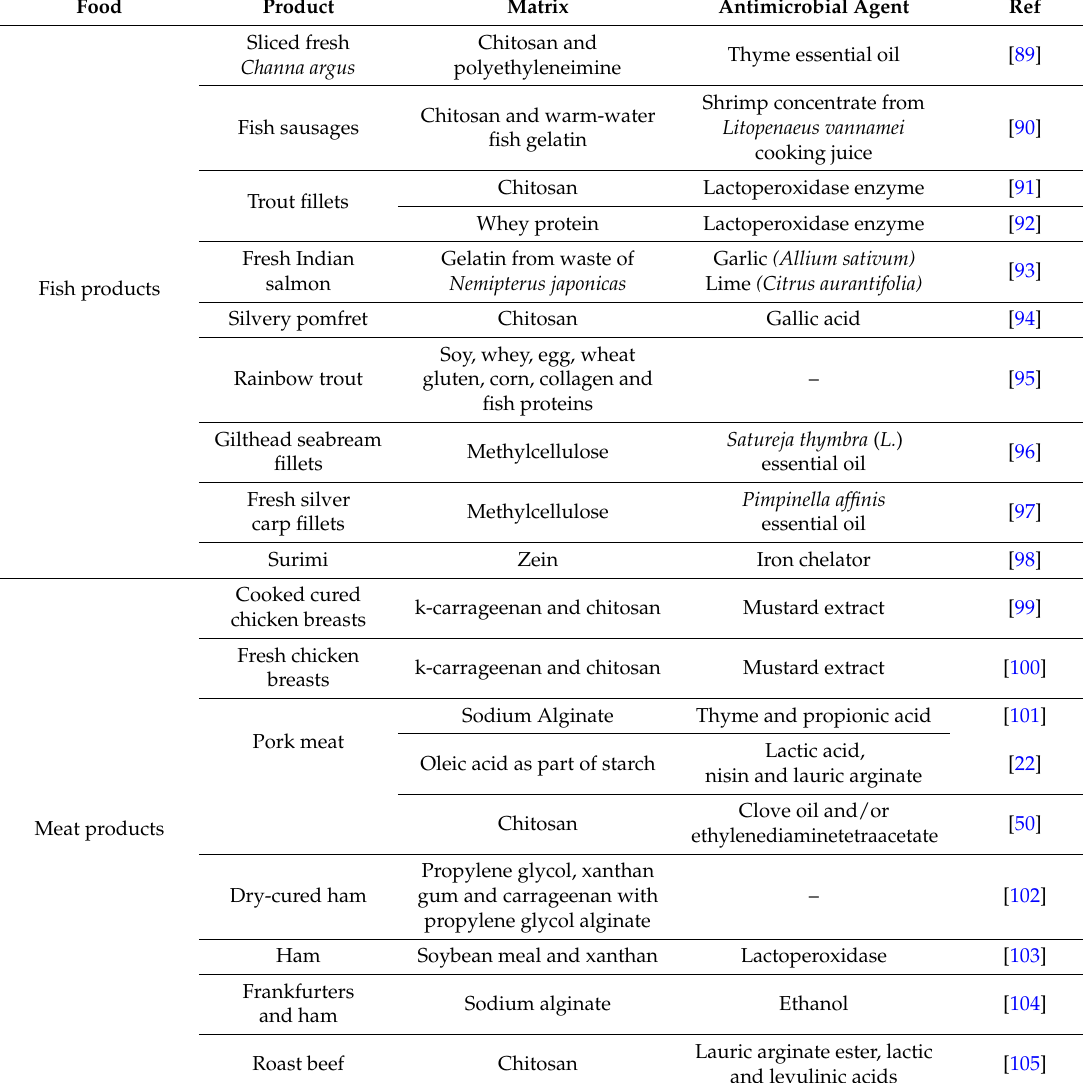
Table 2. Antimicrobial coatings developed for fish and meat